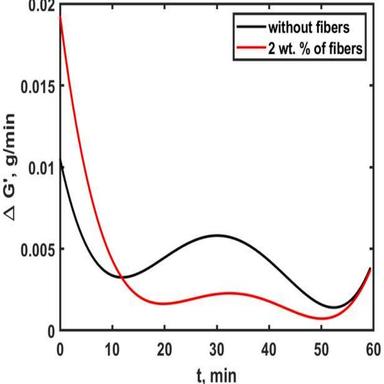
Mass loss rate of observed specimens obtained from the polynomial fit results for specimens.